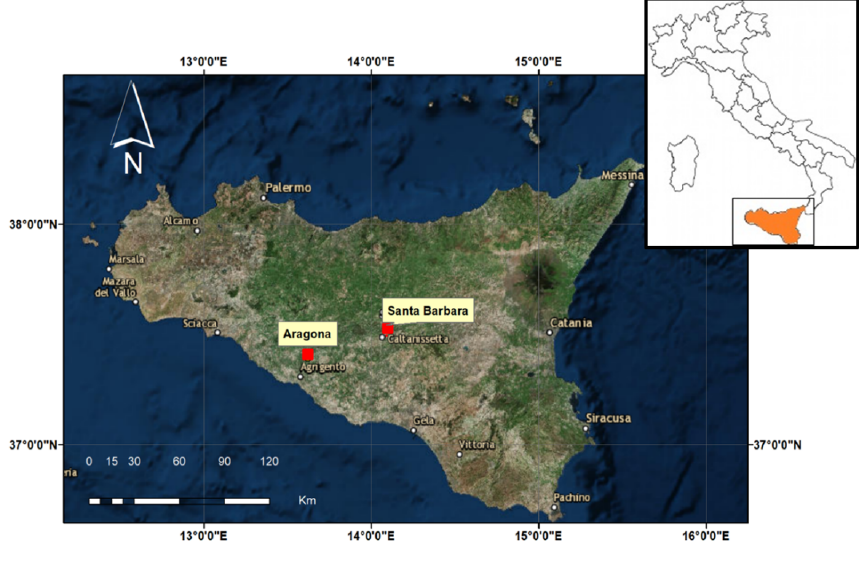
Figure 1. Location of the two investigated mud volcano areas: Santa Barbara (Caltanissetta Province) and Aragona (Agrigento Province) (image from ESRI).